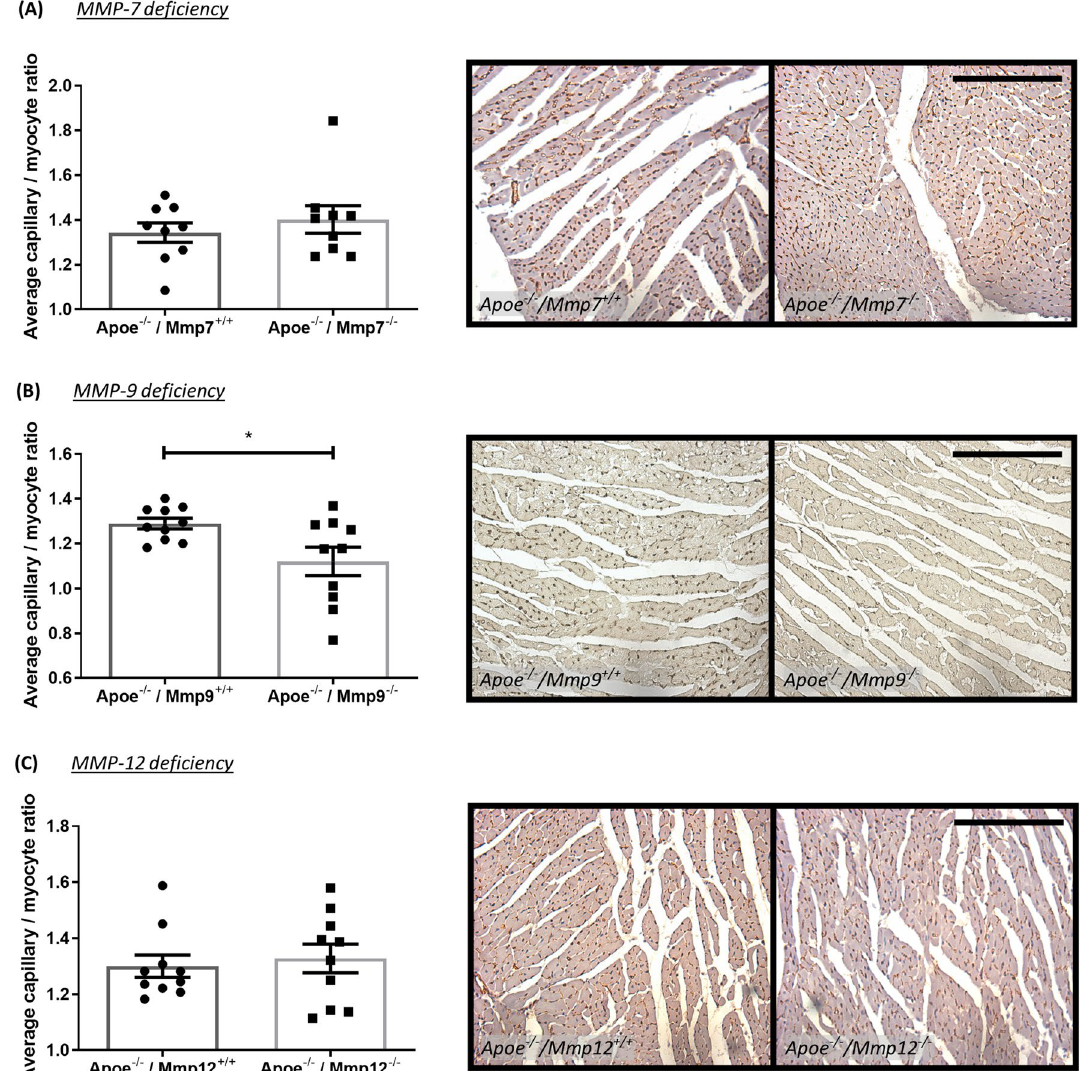
Figure 7. Effect of MMP modulation on capillary to myocyte ratio in apolipoprotein E-deficient (Apoe - /- ) mice. Quantification and representative images of capillary to myocyte ratio as assessed in isolectin B4-immunohistochemically stained hearts from 36-week high-fat fed Apoe -/- mice deficient for ( A ) MMP-7, ( B ) MMP-9, and ( C ) MMP-12, in comparison to their respective Apoe single knockout controls. Capillary to myocyte ratio is presented as average/heart cross-section/mouse. Statistical significance is reported as * P < 0.05 using unpaired Students t-test. Scale bar represents 1 mm and is applicable to all panels. In A, n = 9/group; in B and C, n =